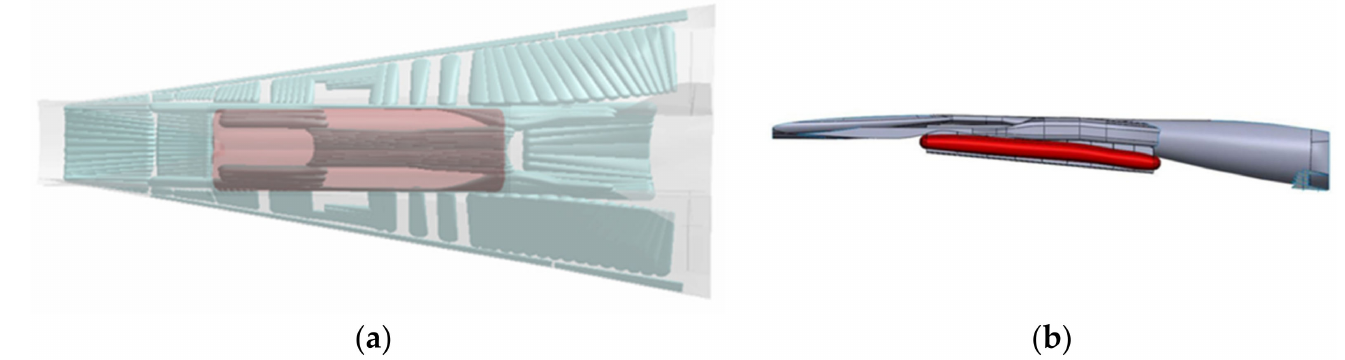
Figure 10. ( a ) Top view of the STRATOFLY MR3 and the cabin; ( b ) side view of the STRATOFLY MR3 and the